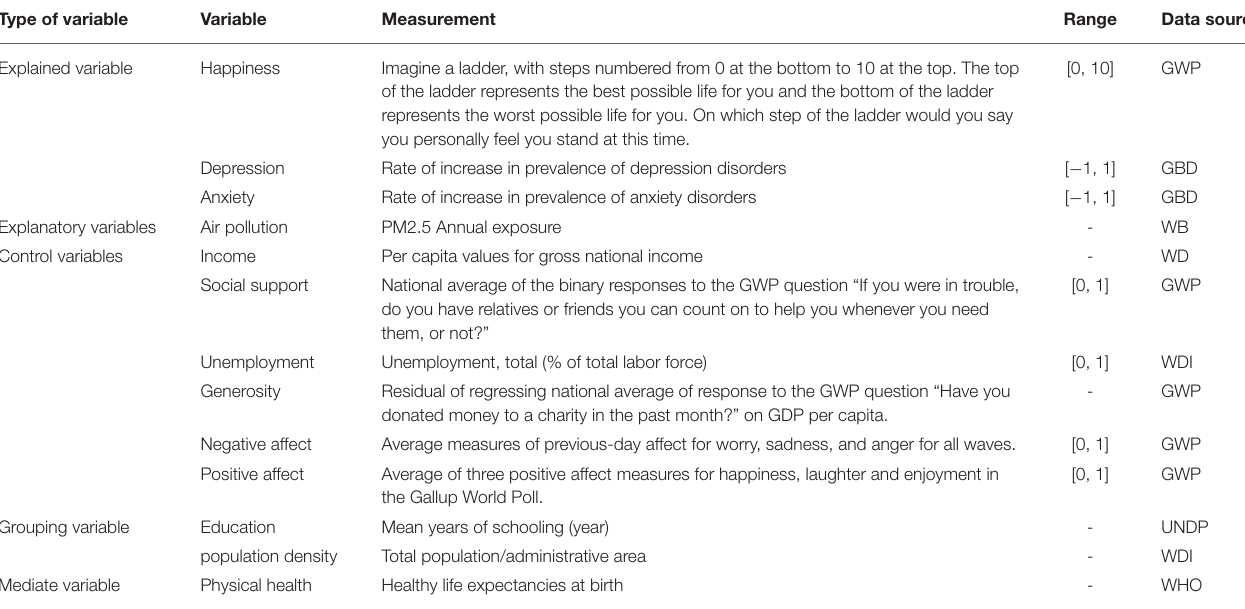
TABLE 1 | Variables measurement and data source.